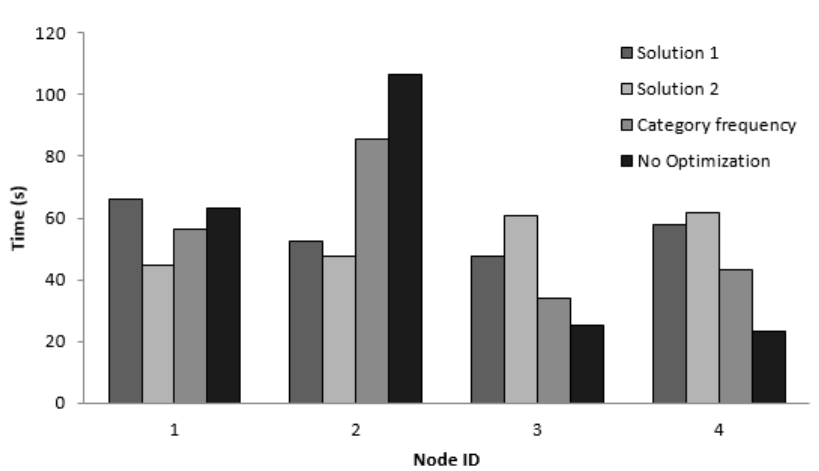
Figure 7. Reuters data, four nodes, homogeneous environment.